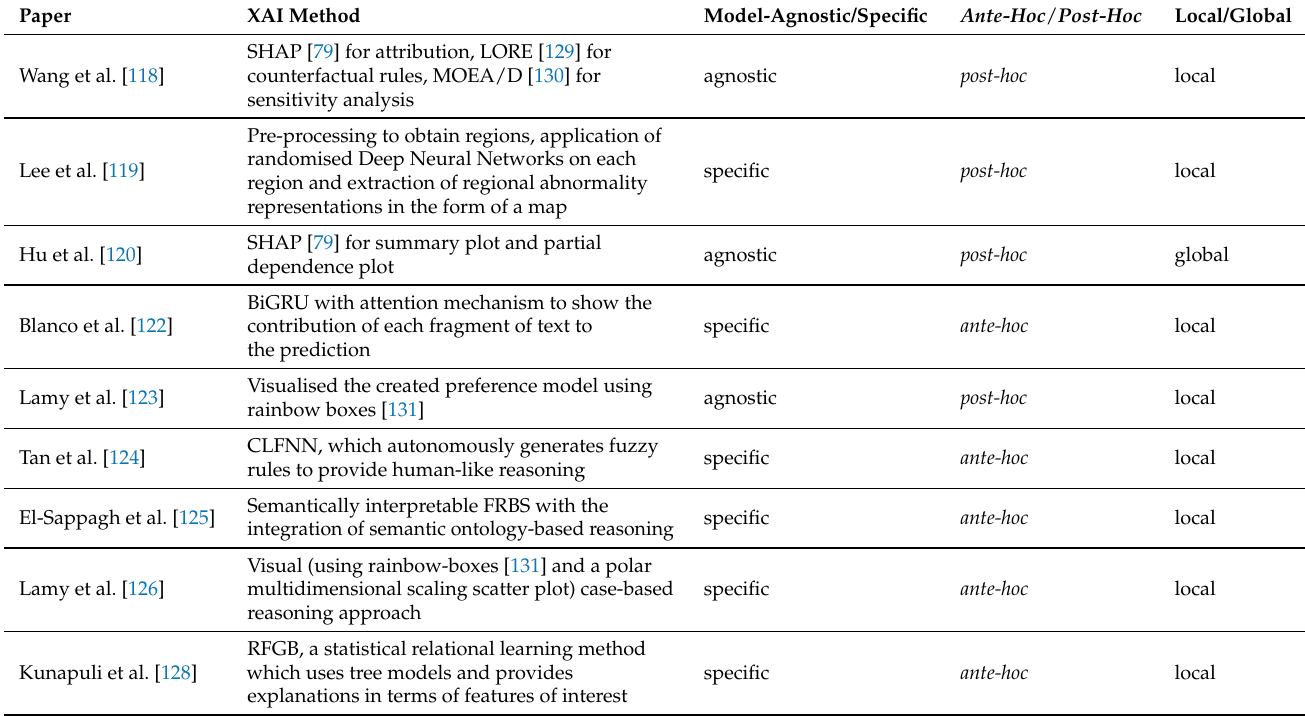
Table 2. CDSS classified by XAI